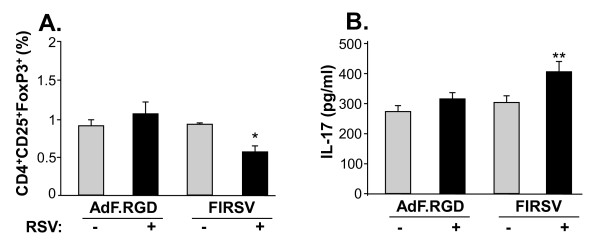
Treg cells (CD4+, CD25bright, FoxP3+) and IL-17 level following infection with RSV in immunized mice. BALB/c mice were immunized subcutaneously with AdF.RGD (1010 pu/mouse) or FIRSV (105 pfu). A, B. Five wk later the mice were challenged intranasally with RSV (106 pfu) for 6 days and lung suspensions were analyzed for Treg cells by flow cytometry and IL-17 cytokine level. A. Treg cells. B. IL-17. Data are presented as mean ± SEM of 4 mice/group from one of two independent experiments.* and ** denote significance of p < 0.05 and p < 0.01, respectively.